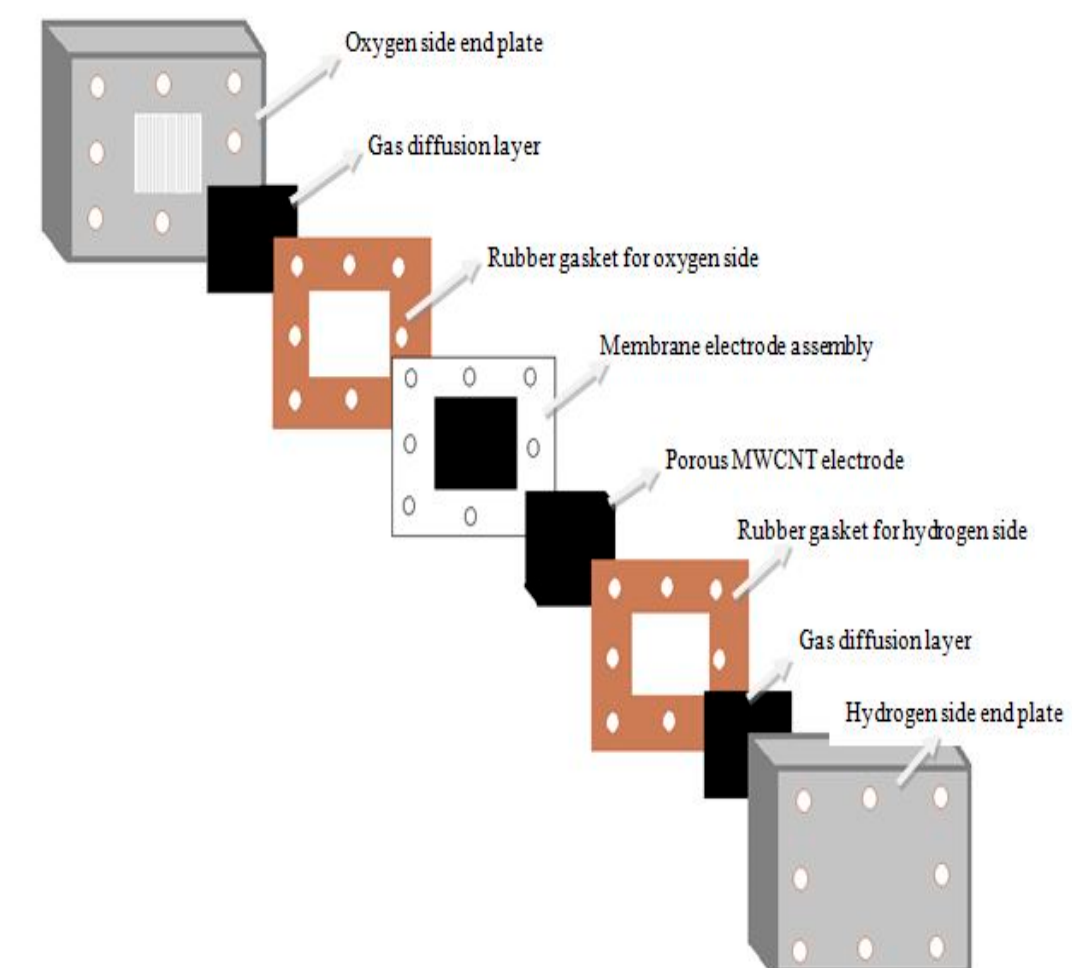
Figure 8. Schematic diagram of orientation for a modified unitized regenerative fuel cell URFC.